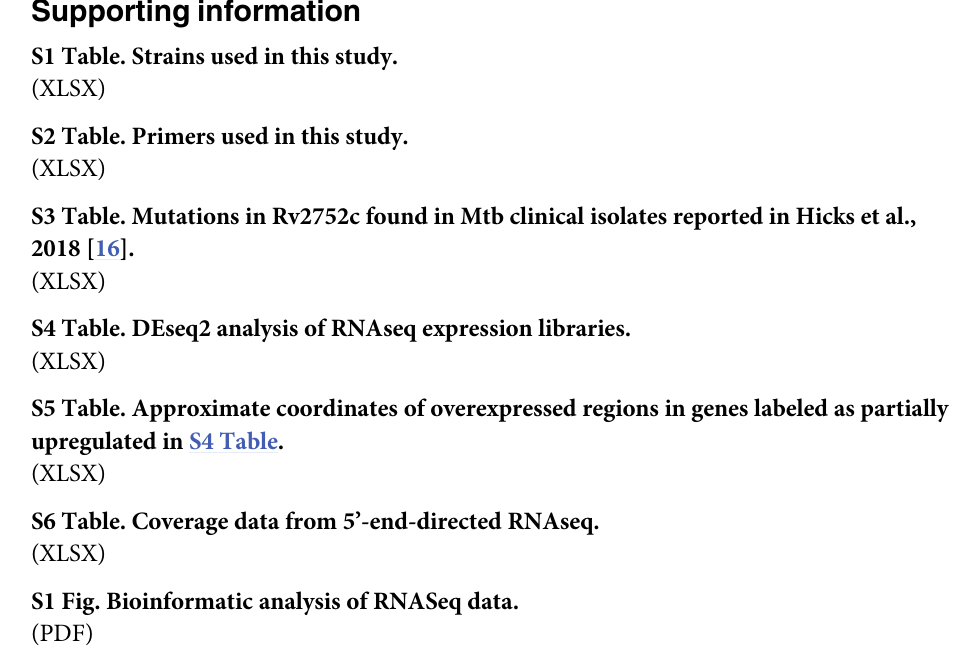
S3 Table. Mutations in Rv2752c found in Mtb clinical isolates reported in Hicks et al.,